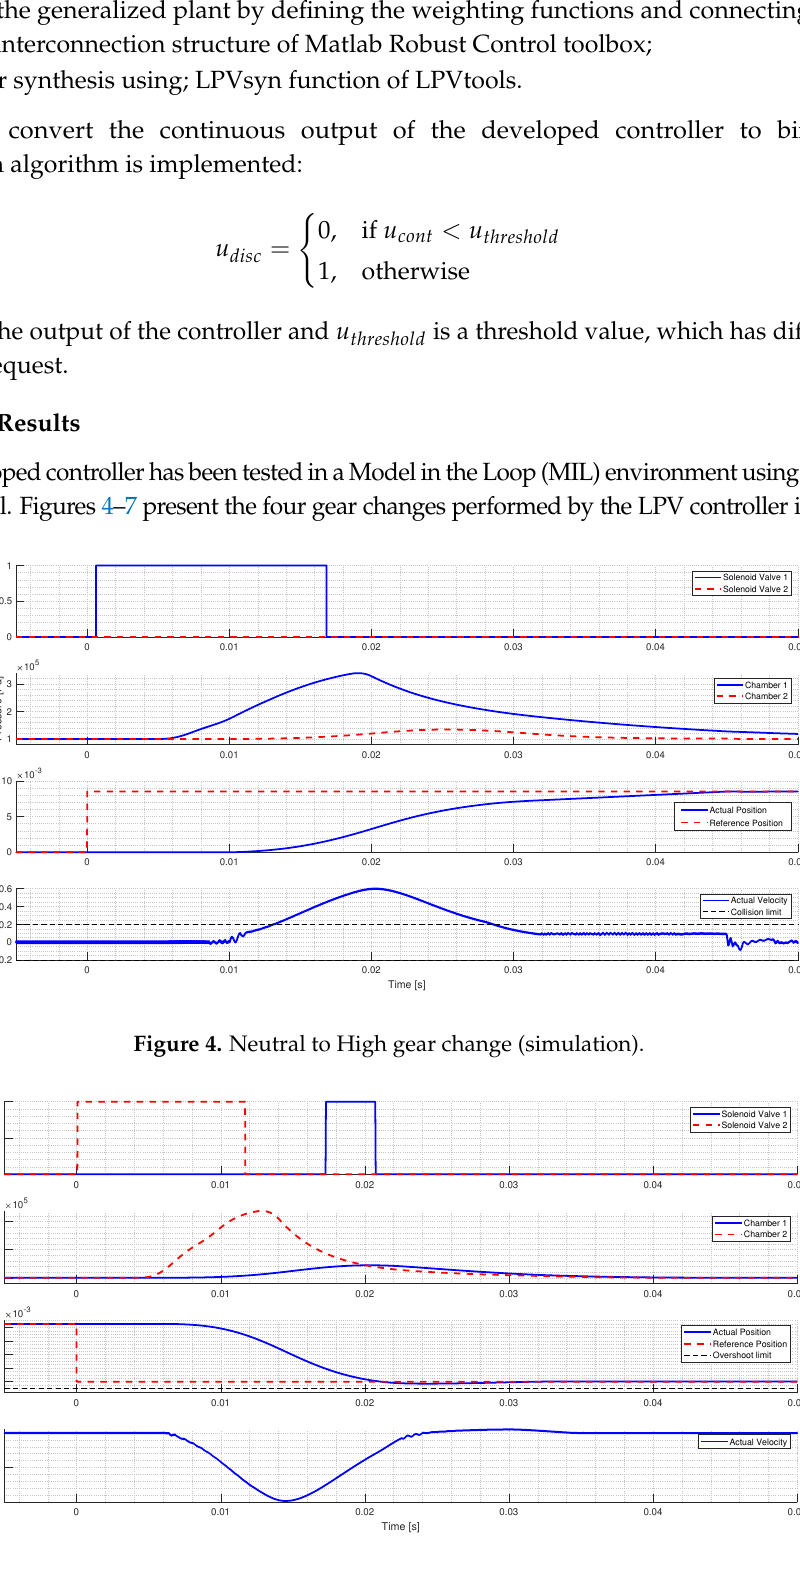
Figure 5. High to Neutral gear change